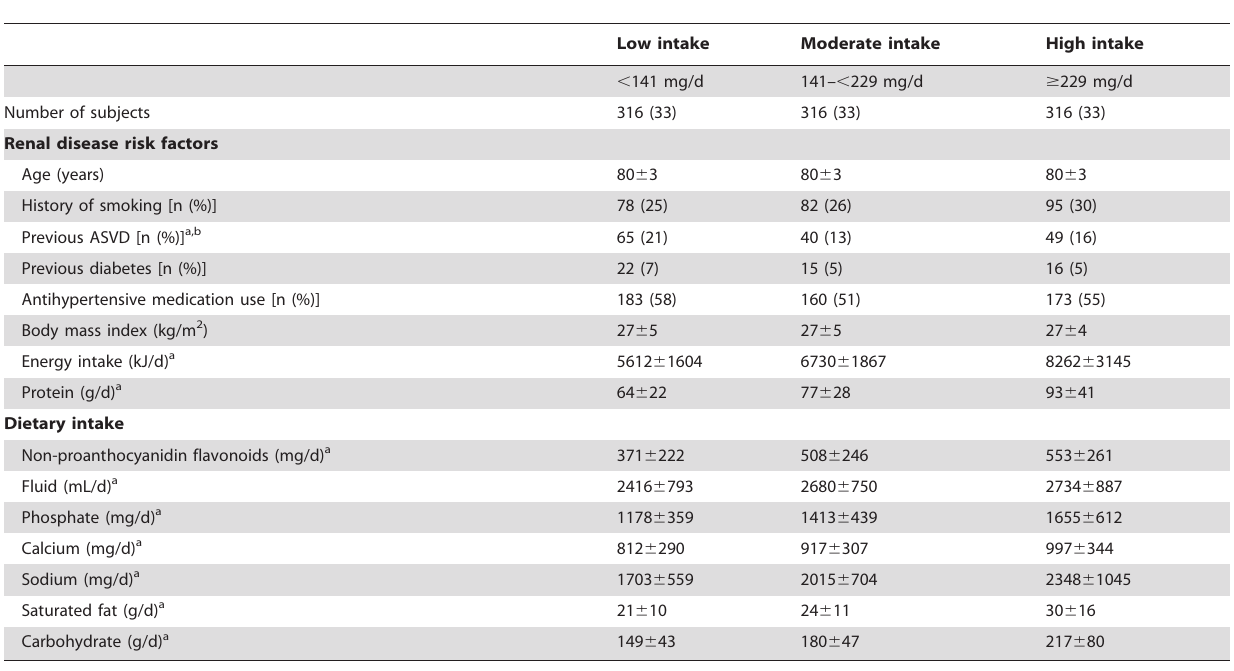
Table 1. Baseline, lifestyle and cardiovascular risk factors by tertiles of proanthocyanidin intake.